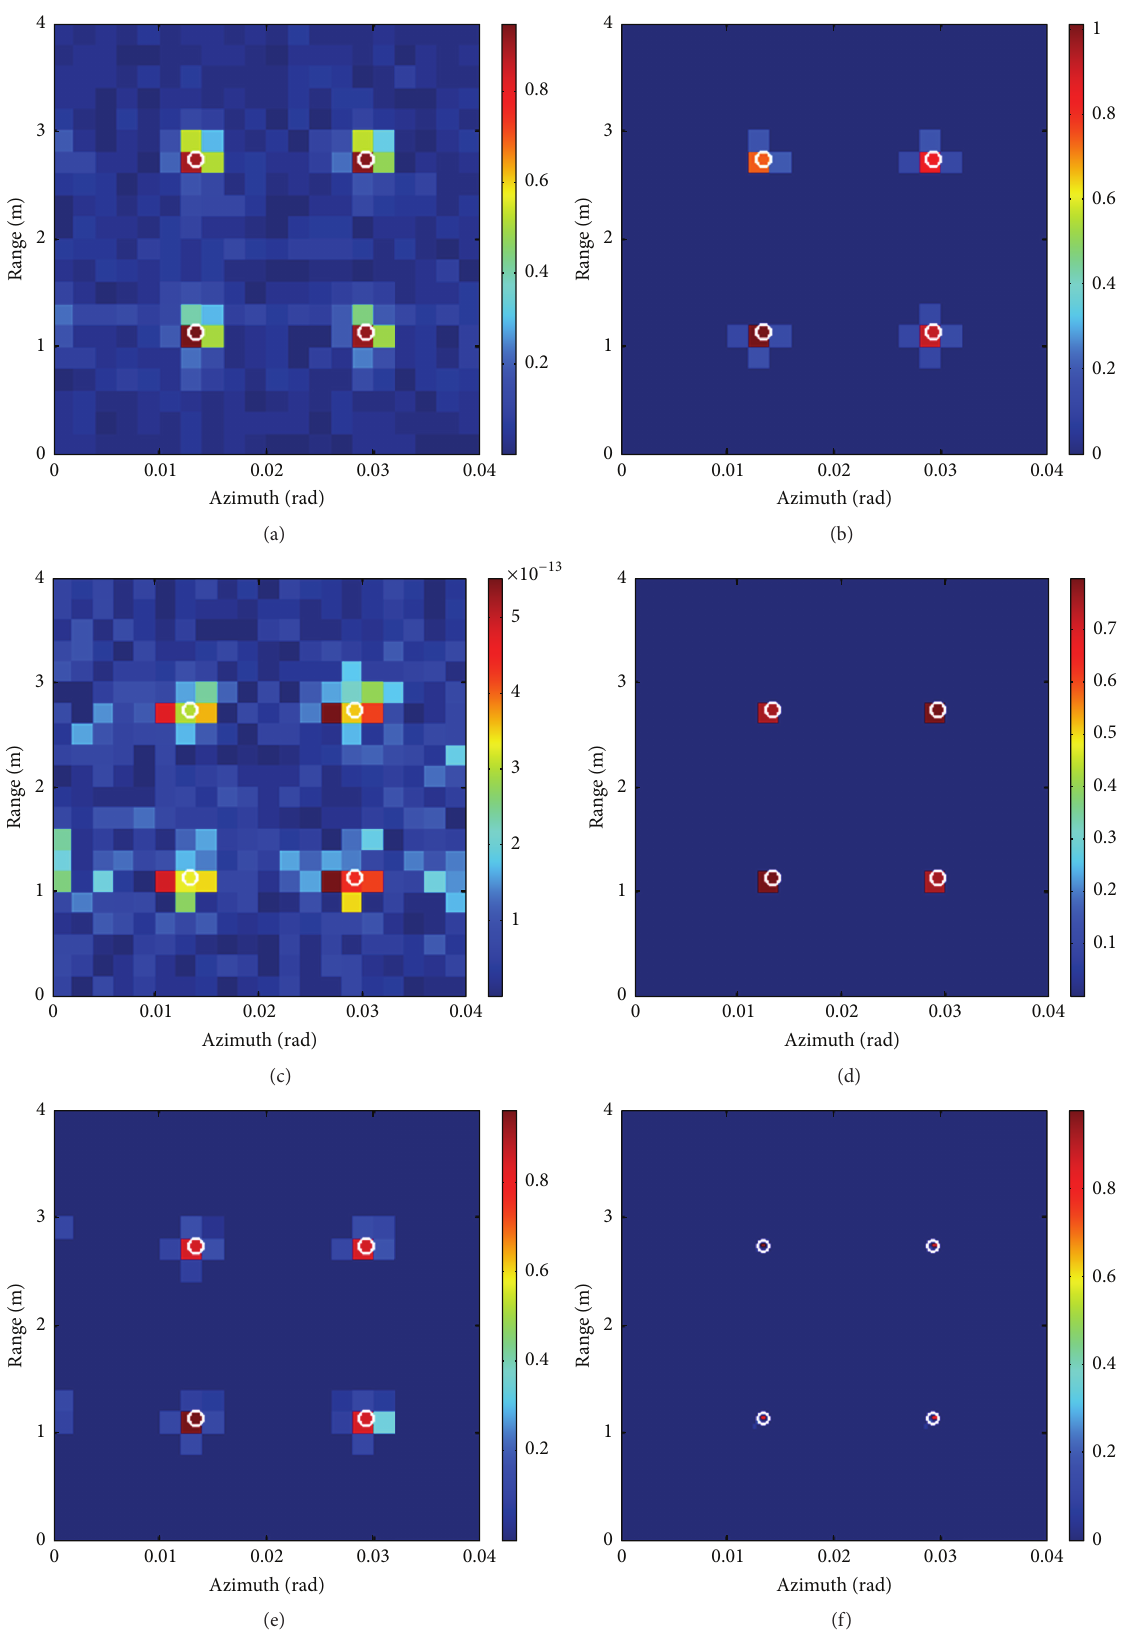
Figure 6: Off-grid RCI results. (a) MF, (b) OMP, (c) BPDN, (d) S-TLS, (e) CP, and (f) 2D